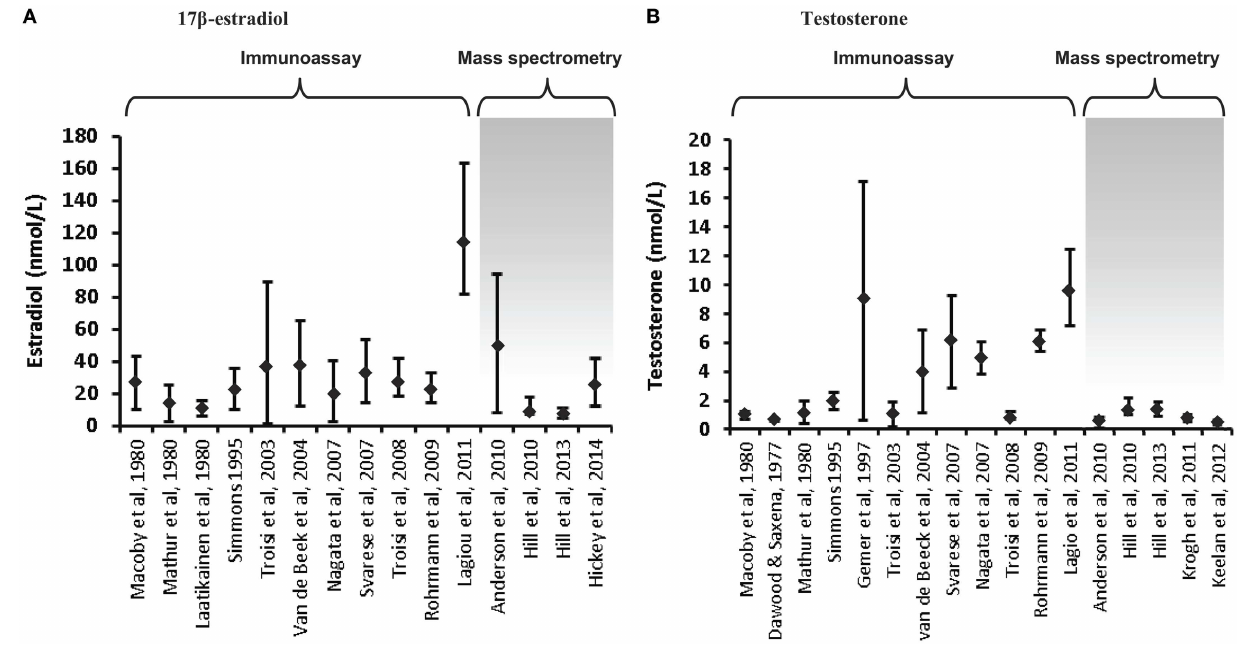
FIGURE 1 |Variations in umbilical cord blood steroid concentrations according to mode of assay . Steroid concentrations in cord blood are displayed as mean ± standard deviation or median and interquartile range, depending on the data available. (A) 17 β -estradiol concentrations in cord blood (males and females combined) are displayed from 15 studies.The first 11 utilized immunoassay (predominantly RIA); the remaining 4 used LC–MS/MS, apart from the studies by Hill et al. (41), which used GC–MS. (B) Testosterone concentrations in cord blood (males or mixed